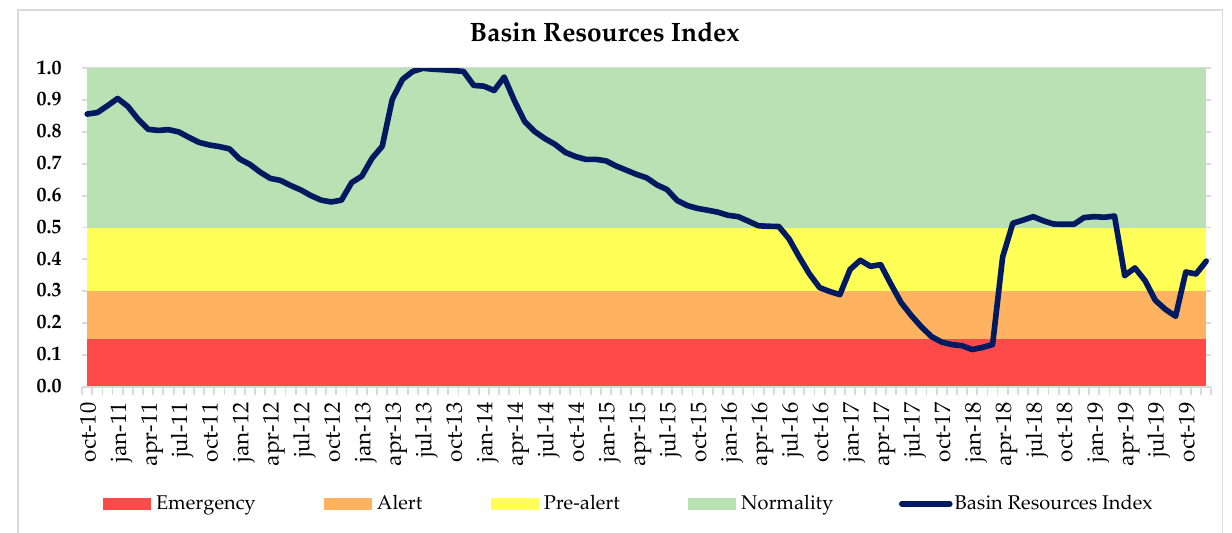
Figure 10. Evolution of the index of the basin resources (temporary scarcity) in the Segura Basin, period October 2010–December 2019. Source: own elaboration based on [64].